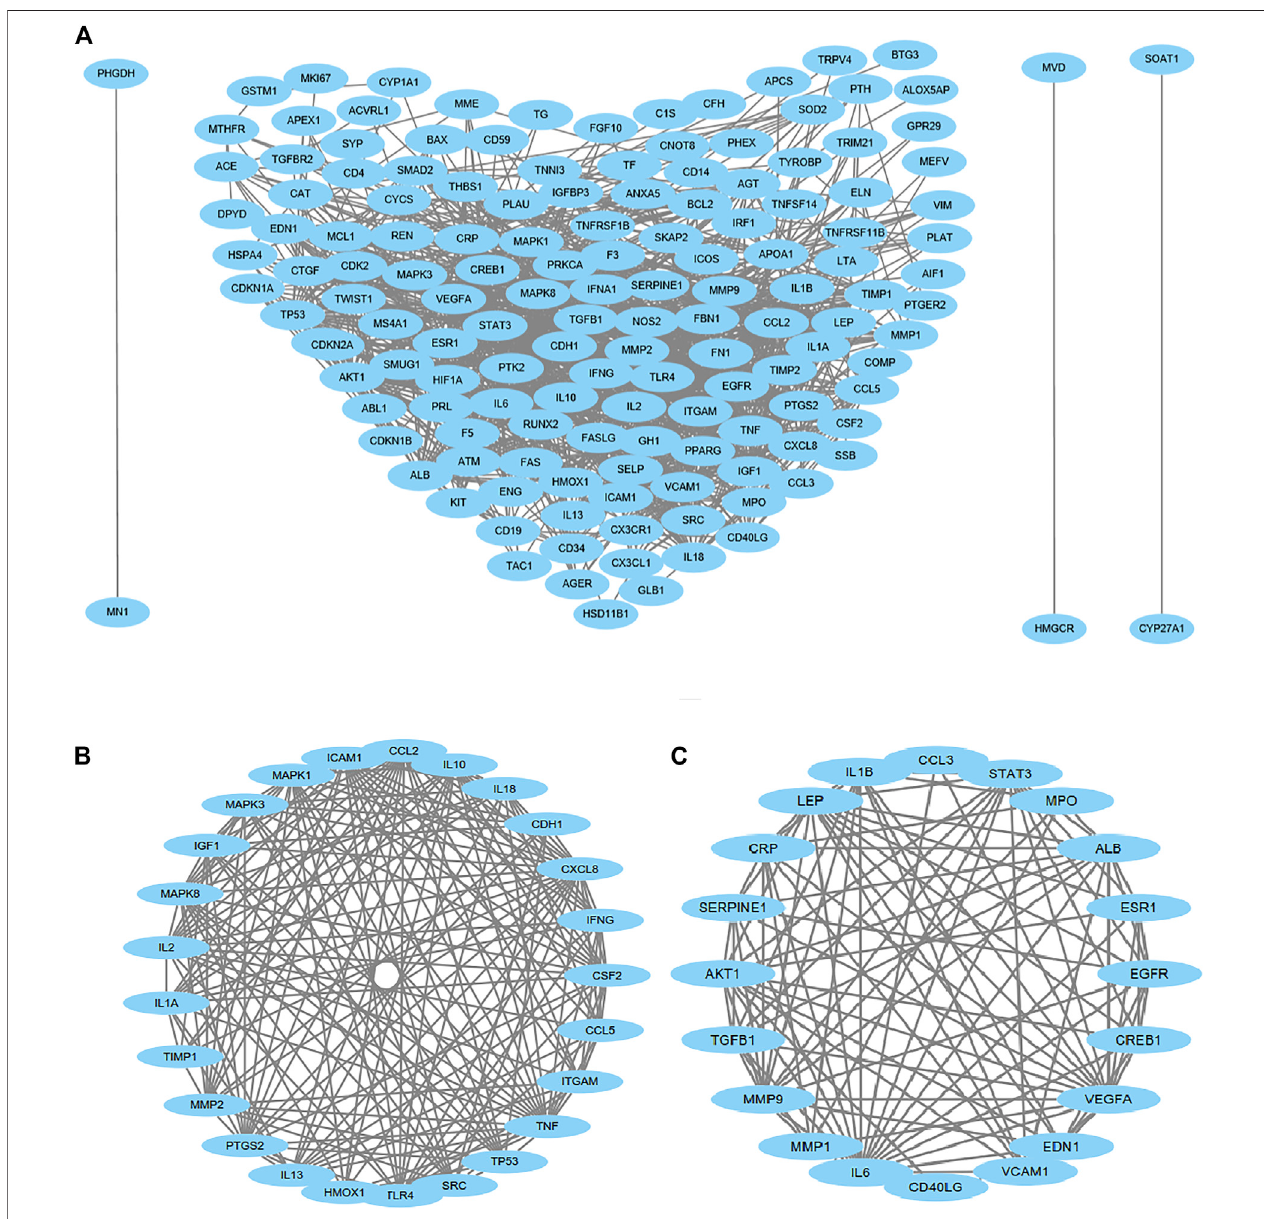
FIGURE 5 | Protein – protein interaction (PPI) network analysis. PPI of 149 genes/nodes with scores > 0.9 (high con fi dence) and 1,205 edges are shown in (A) , and 30 genes have been excluded because of low con fi dence. For the most signi fi cant gene modules, two signi fi cant gene modules were clustered by using the MCODE application. Module 1 consisted of 25 genes/nodes and 180 edges (B) , and module 2 was made up of 20 genes/nodes and 104 edges (C) .